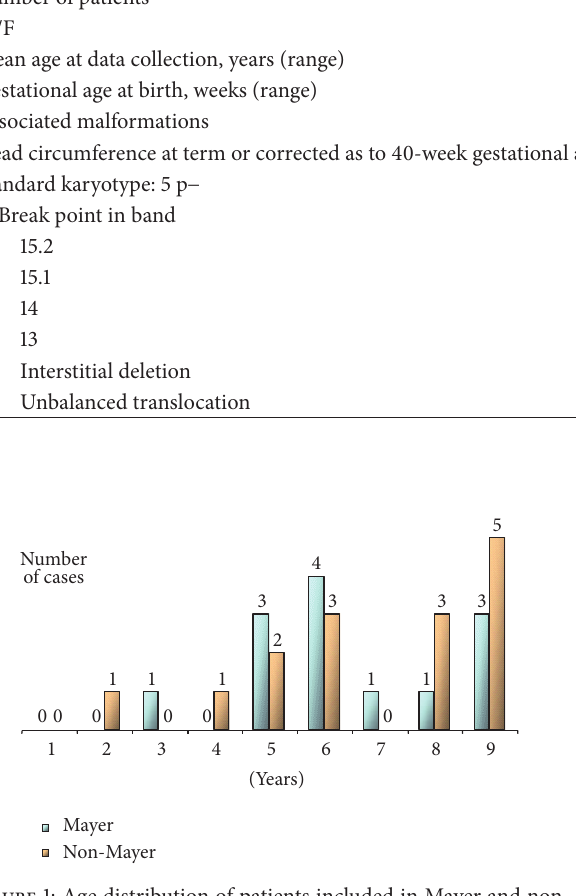
Figure 1: Age distribution of patients included in Mayer and non- Mayer Project.